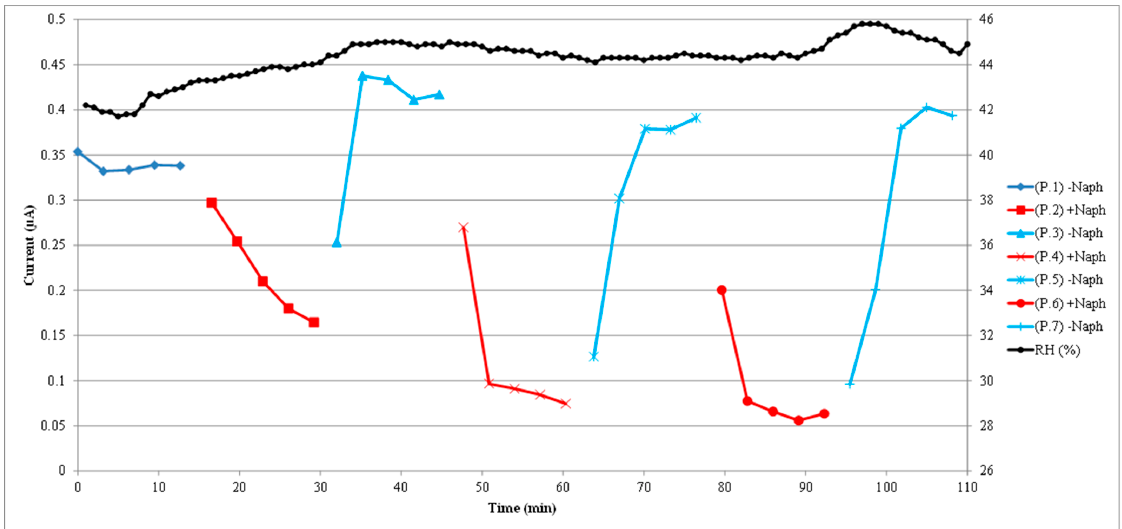
Figure 7. Same sensor current response presented in Figure 6, but now correlated to the air relative